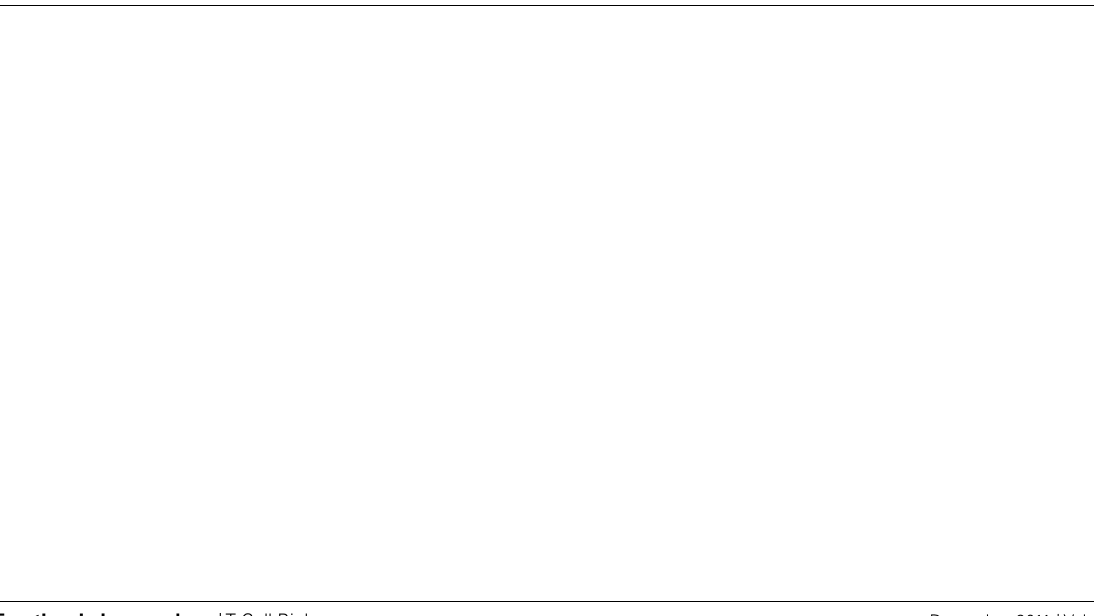
FIGUREA11 | MS 2 449.75 of HLA-A2 bound peptides is almost universally dominated by the fragmentation of LLDVPTAAV from the GILT signal peptide. The lack of this signature in tumor sample KTS8 was exceptional and immediately noted. (A) MS 2 449.75 of synthetic peptide LLDVPTAAV; (B)